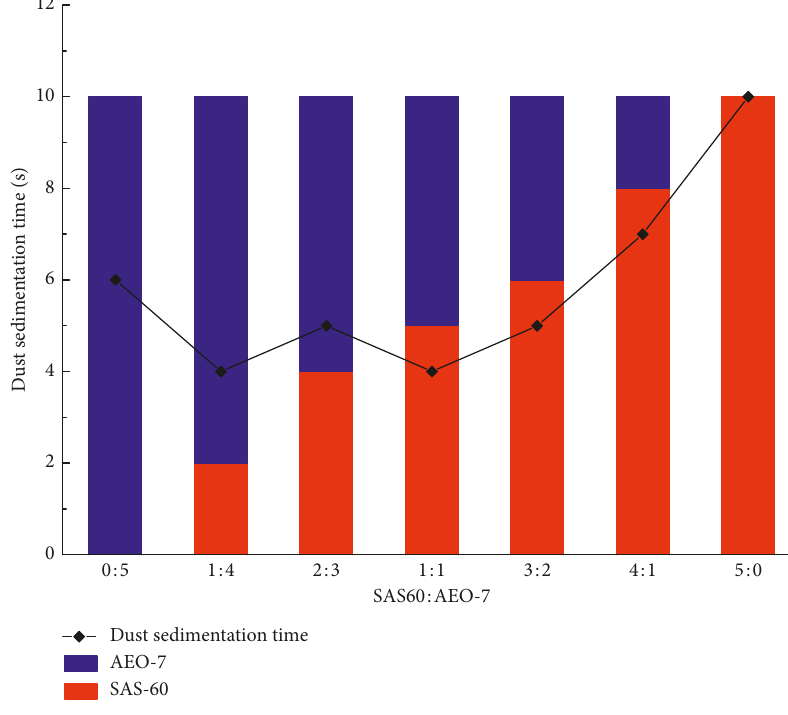
Figure 2: Impacts of the SAS-60 : AEO 7 ratio on the wetting performance results.